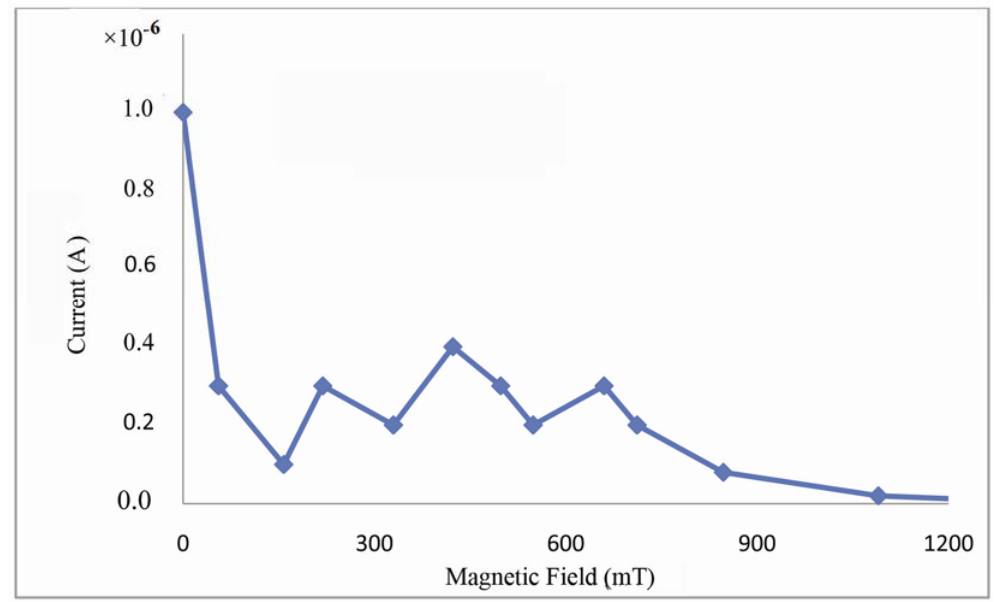
Figure 6. Saturation current versus magnetic field in gold-DNA-gold